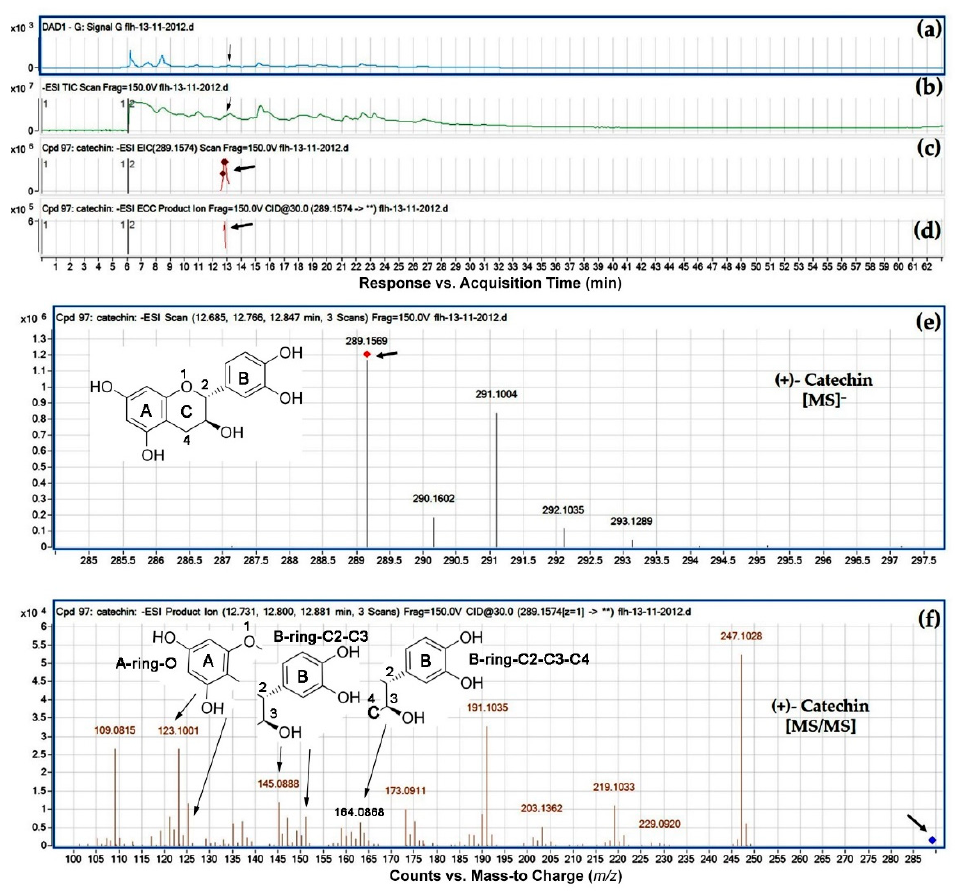
Figure 3. Extracted ion chromatogram (EIC) of primary mass spectrum (MS1) and m / z features of secondary ion fragments (MS2) derived from HPLC-qTOF-MS/MS annotate this peak to be (+)-catechin, (MW, 290.26). ( a ) Chromatogram of FLH 13-11 extract (2012) recorded at 280 nm, ( b ) total ion chromatogram of FLH 13-11 extract (2012), ( c ) EIC of primary ion 289.1574 [M − H] − , ( d ) enhanced charge capacity (ECC) ion product for m / z 289.1574, ( e ) a MS profile showing an extracted m / z 289.1569, and ( f ) fragments from collision-induced dissociation (CID) of m / z 289.1569 showing m / z 109.0815, 121.0136, 123.1001–125.0089, 137.0078, 145.0888–151.0230, 159.0238–164.0868, 173.0911, 191.1035, 203.1362, 219.1033, 229.092, and 247.1028 (Table 1).